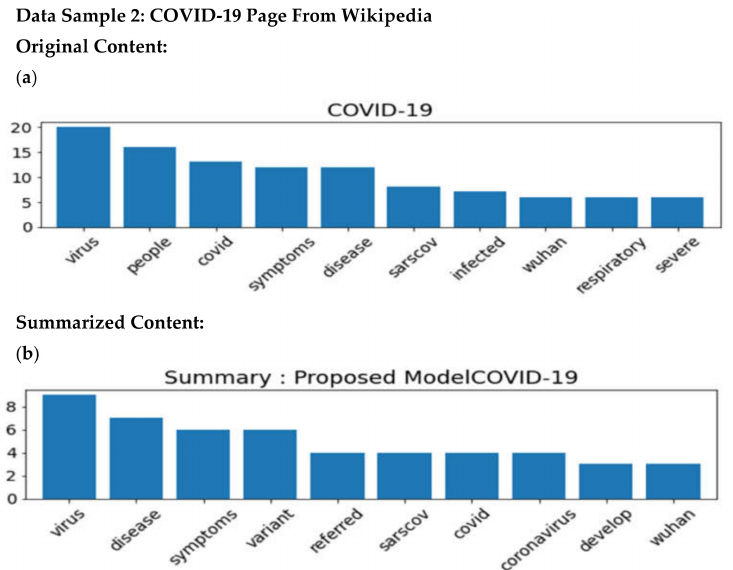
Figure 3. ( a ) Shows the number of semantic words and their frequency in the document. ( b ) Shows the number of semantic words and their frequency in the document.